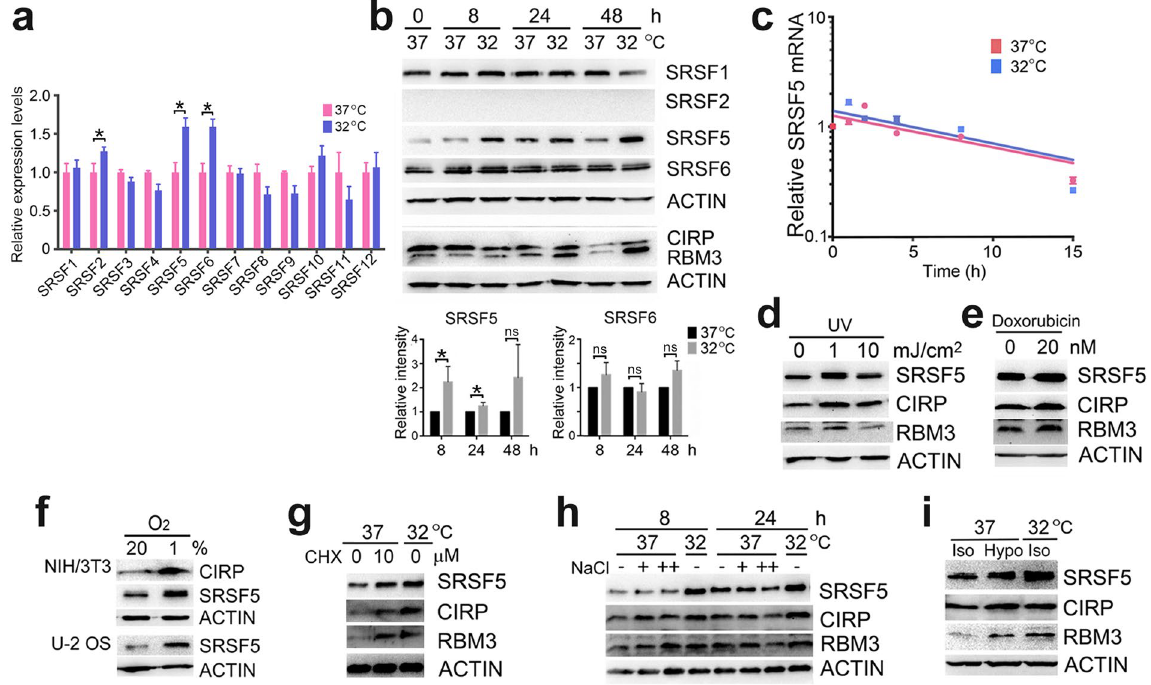
Figure 1. Induction of SRSF5 protein by various stresses. ( a ) Comparison of transcript levels of SRSF family members (1 to 12) in U-2 OS cells cultured at 37 °C or 32 °C for 6 h. mRNA abundance at 32 °C relative to that at 37 °C after normalization to 18S rRNA was determined for each SRSF member by quantitative RT-PCR (data indicate mean ± SEM; n = 3 per group). Statistical significance was determined by Student’s t -test. * , P < 0.05. ( b ) Protein levels in U-2 OS cells cultured at 37 °C or 32 °C for indicated times were analyzed by western blot (upper panels, representative results). Band intensities relative to those at 37 °C were determined after normalization to ACTIN (lower graphs, data indicate mean ± SEM; n = 3). The samples derived from the same experiment and gels/blots were processed in parallel. Statistical significance was determined by Student’s t -test. * , P < 0.05. ns, P > 0.05. ( c ) U-2 OS cells were cultured at 37 °C or 32 °C in the presence of 5 μ g/ml actinomycin D for indicated times. SRSF5 mRNA levels relative to those at time 0 were determined by quantitative RT-PCR after normalization to 18S rRNA (data indicate mean ± SEM; n = 3). ( d and e ) U-2 OS cells were cultured at 37 °C for 8 h after exposure to indicated doses of UV ( d ) or in the presence or absence of 20 nM doxorubicin ( e ). Cell lysates were analyzed by western blot (representatives of 4 or 3 independent experiments). ( f ) NIH/3T3 and U-2 OS cells were cultured at 37 °C under normoxia (20%) or hypoxia (1% O 2 ) for 8 h, and analyzed by western blot (representative of 4 independent experiments). ( g ) U-2 OS cells were cultured at 37 °C for 12 h in the presence of indicated doses of cycloheximide (CHX), and analyzed by western blot (representative of 5 independent experiments). ( h ) U-2 OS cells were incubated with regular media ( − ) or media containing additional 60 ( + ) or 160 ( ++ ) mM NaCl at 37 °C for 8 or 24 h, and analyzed by western blot (representative of 4 independent experiments). ( i ) U-2 OS cells were incubated with regular media (Iso) or hypotonic media containing 10% (volume/volume) of H 2 O (Hypo) at 37 °C for 8 h, and analyzed by western blot (representative of 3 independent experiments). Full-length blots are presented in Supplementary Fig.